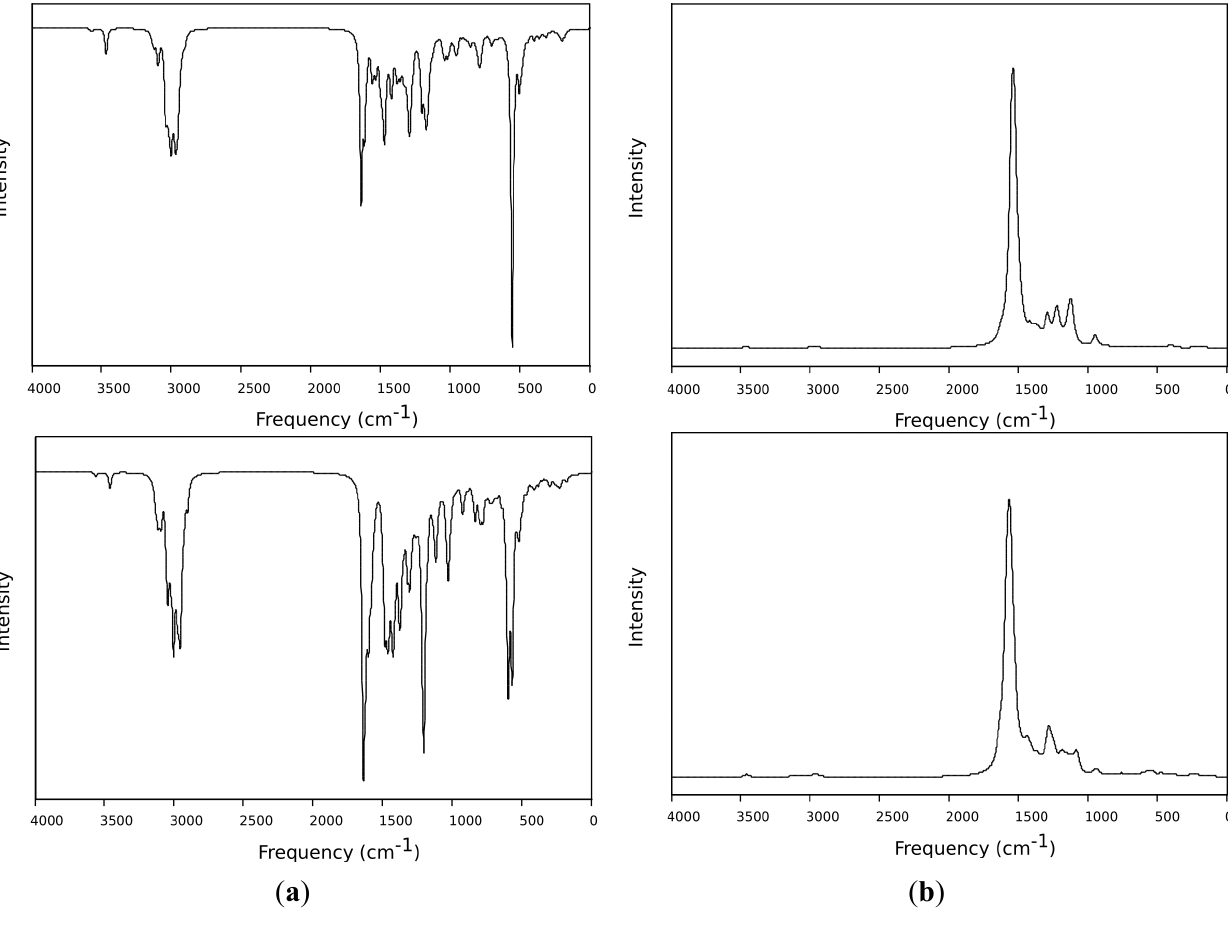
Figure 7. ( a ) IR spectra of OIC1MS (above) and OIC2MS (below) calculated at the PBEPBE/6-31G* level of theory. ( b ) Raman spectra of OIC1MS (above) and OIC2MS (below) calculated with the same methodology as the